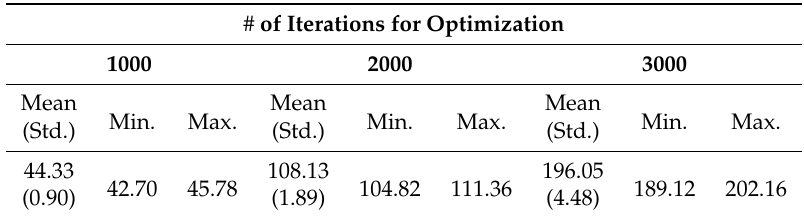
Table 2. Computational times (s) for constructing a navigable graph structure when the numbers of path optimization iterations